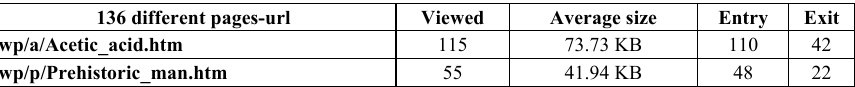
Table 4. Snapshot from page view analytics using